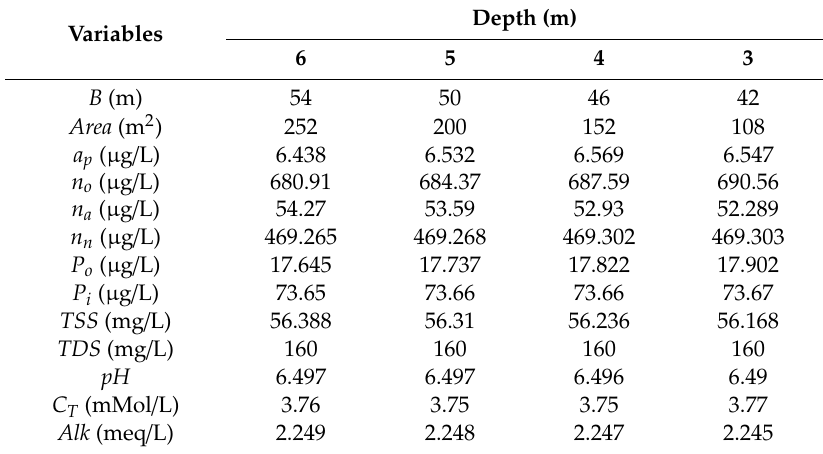
Table 10. E ff ect of water depth ( d ) on di ff erent water quality variables.